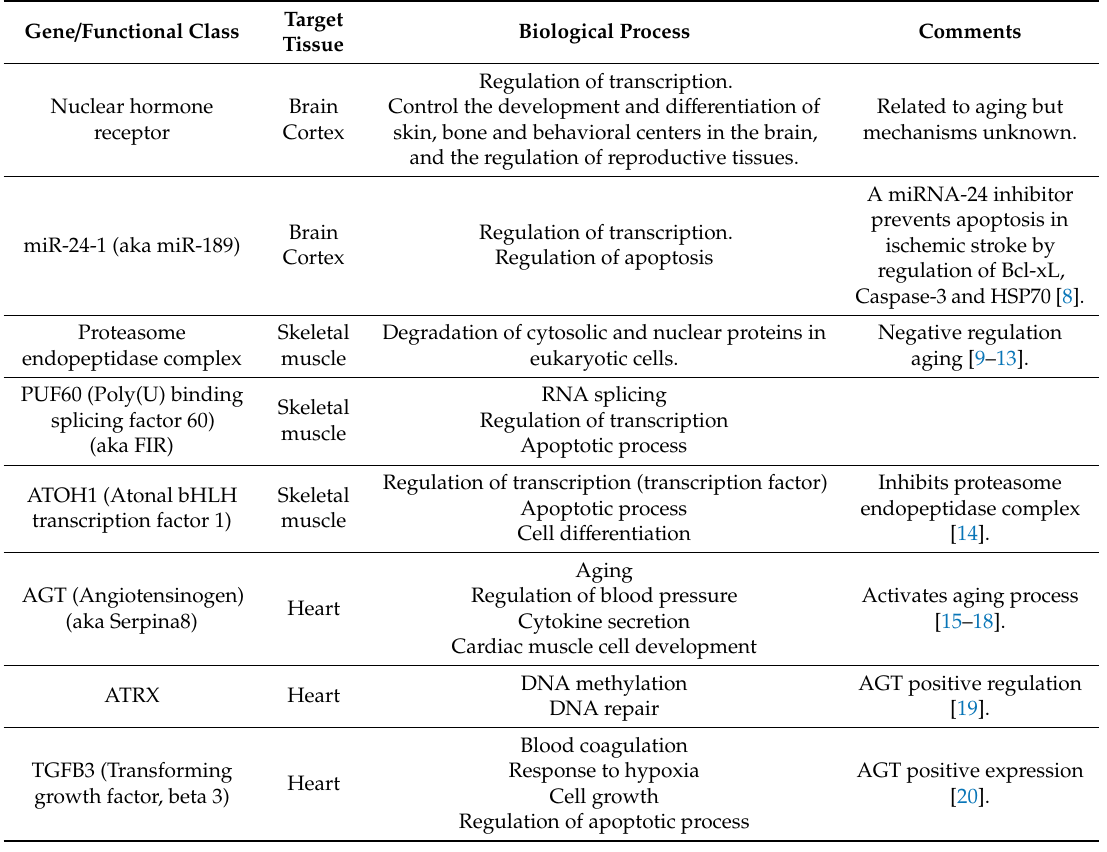
Table 2. Function of master regulator genes identified in the tissues